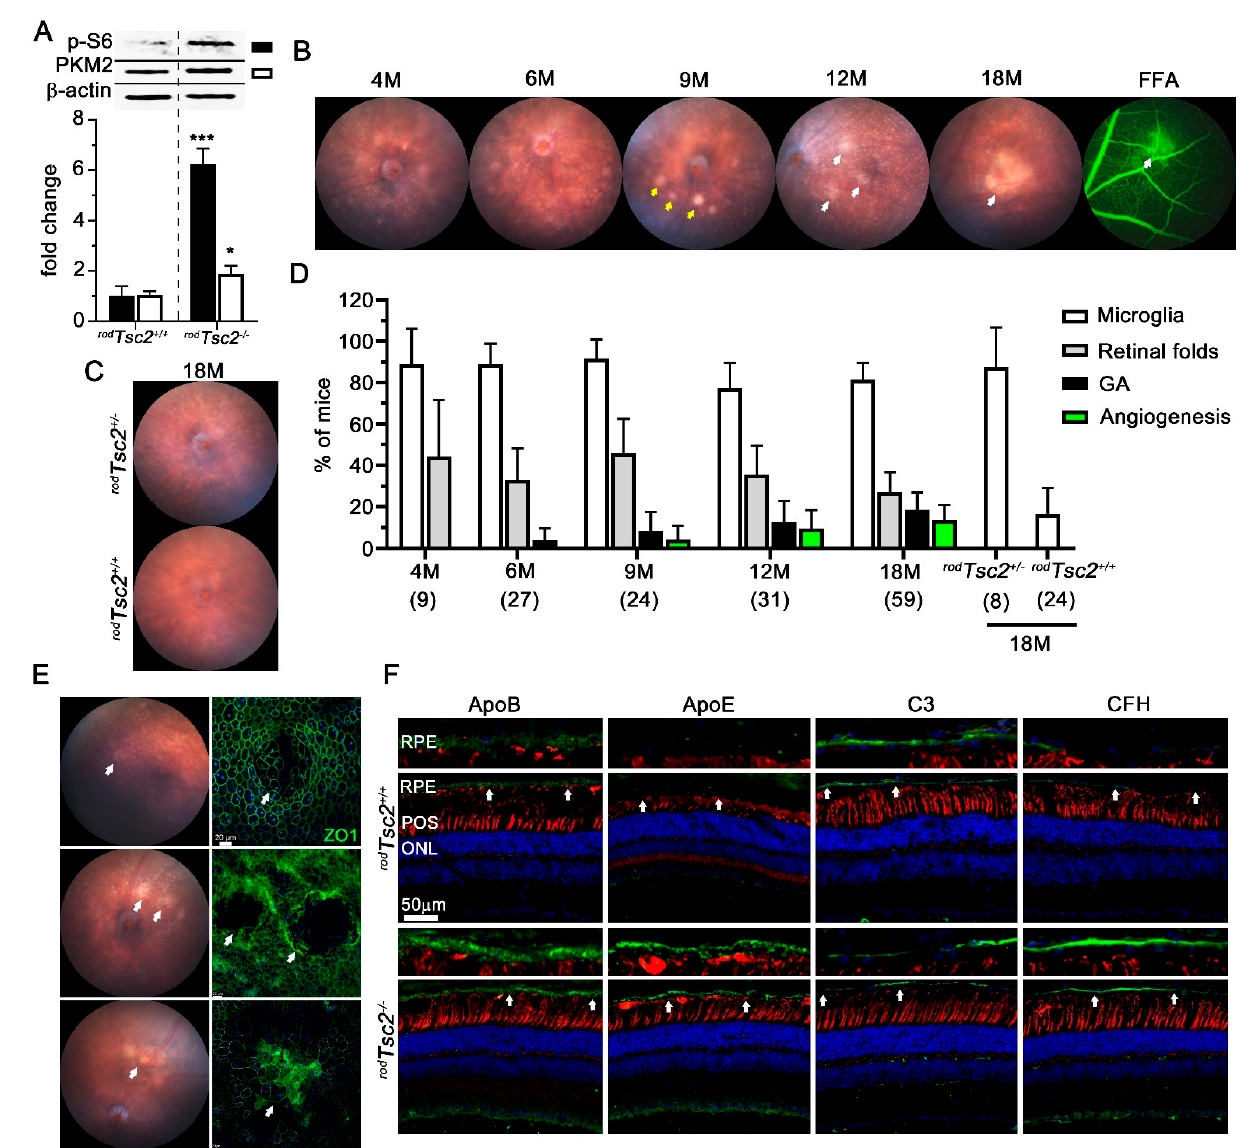
Figure 1. rod Tsc2 − / − mice develop AMD-like pathologies. ( A ) Western blot quantifications performed with 2 months (M) old mice for p-S6 (black bar) and PKM2 (white bar) expression levels in rod Tsc2 +/+ and rod Tsc2 − / − mice ( n = 4 mice). On top are representative Western blot images for p-S6 (32kDa), PKM2 (60kDa), and the β -Actin control (45kDa). Relative fold changes are shown. Error bars: S.E.M., * p < 0.05; *** p < 0.001. ( B ) Fundus and fundus fluorescein angiography (FFA: right) images of rod Tsc2 − / − mice over time (yellow arrows: retinal folds; white arrows: GA or neovascular pathology in FFA image; prominent white dots on fundus image of 12 M are microglia). ( C ) Representative fundus images of rod Tsc2 +/ − (top) and rod Tsc2 +/+ (bottom) mice at 18 M. ( D ) Quantification of pathologies seen by funduscopy and FFA in rod Tsc2 − / − mice over time and littermate controls at 18 M. Each bar shows percentage of mice ± M.O.E. Numbers in parentheses represent number of mice analyzed per time point. ( E ) Fundus (left) and RPE flat mount (right; ZO-1: Zona Occludens 1 protein marking tight junctions of RPE cell boundary in green) images showing the development of the different GA types seen in rod Tsc2 − / − mice at 12 M. Slow intermediate GA (top), severe circular formation of GA (middle), and irregular patchy form of GA (bottom) (white arrows: GA lesions). ( F ) Immunofluorescent images of retinal cross-sections from rod Tsc2 +/+ (top) and rod Tsc2 − / − (bottom) mice at 12 M of age showing different AMD-related markers in green: ApoB, ApoE, C3, CFH. Higher magnification of RPE–BrM area marked between the 2 white arrows is shown above each section (blue: DAPI; red: PNA marking cone segments; scale bar = 50 µm).